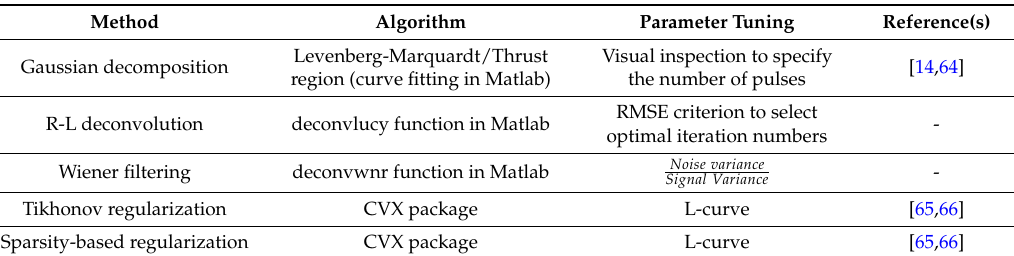
Table 2. Parameter tuning of the